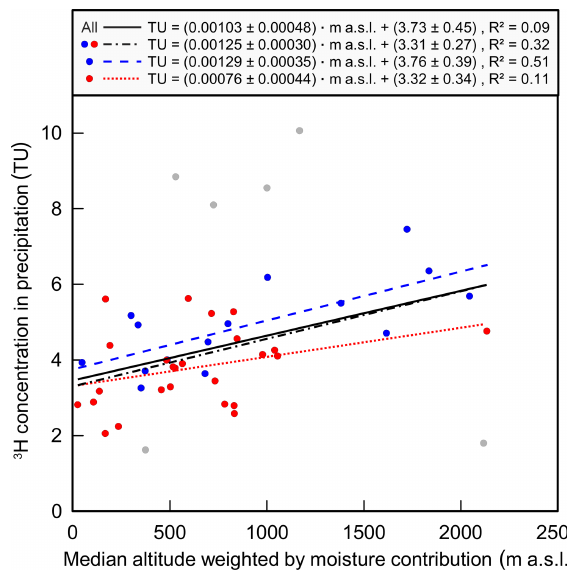
Figure 6. The tritium concentration of precipitation events plot- ted against the median of all event-trajectory points weighted by their moisture contribution based on 10d trajectories. The solid line shows a regression through all data points. The dot-dashed line is the regression through colored data points only, which excludes out- liers above 8TU and below 2TU. The dashed line is the regression through the blue data points that correspond to events from April to June. The dotted line is the regression through red points from the rest of the